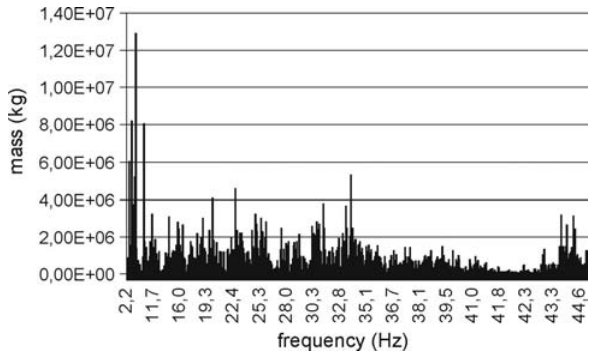
Fig. 7. Distribution of mass involved in individual modes